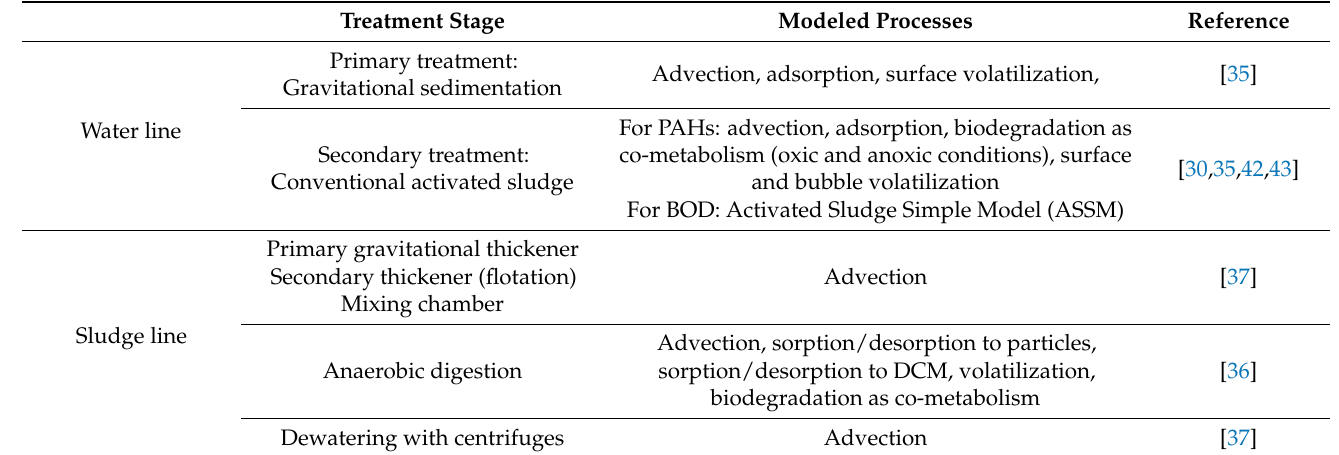
Table 3. Summary of the selected models and processes for each of the treatment